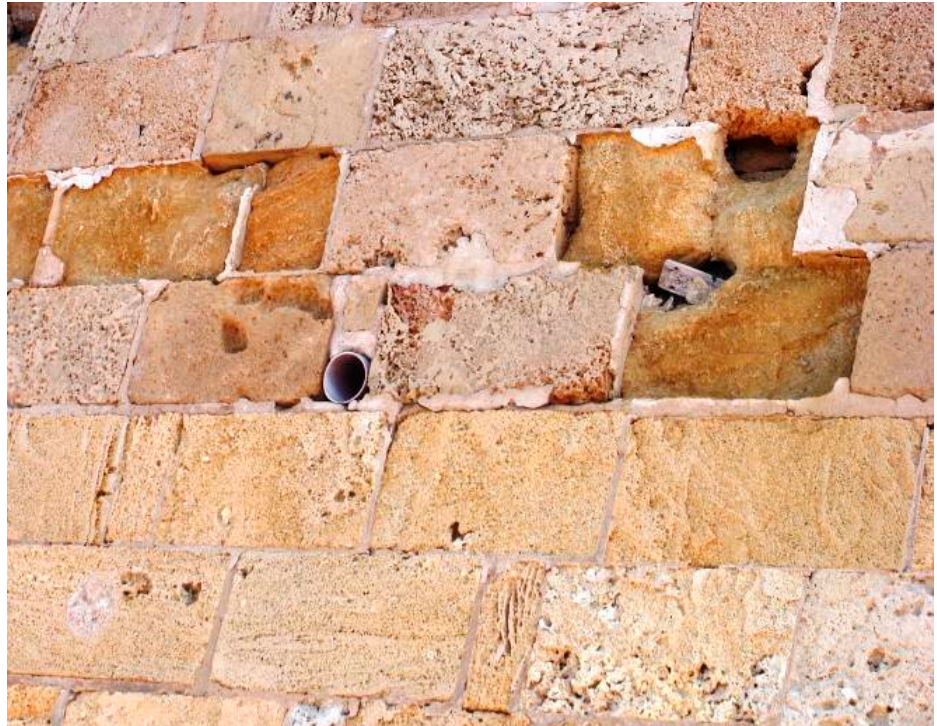
Figure 6. Back weathering of kurkar siding in the Panorama sea walls. Captured by the author on 27 November 2018.